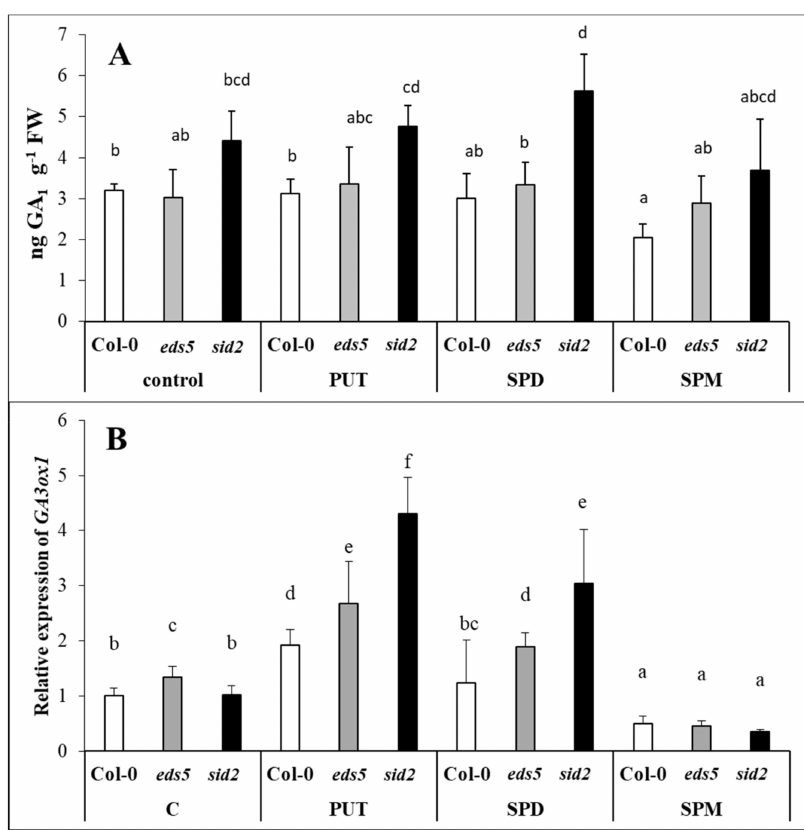
Figure 10. E ff ect of 0.5 mM 1-day of putrescine (PUT), spermidine (SPD) and spermine (SPM) treatments on the content of gibberellic acid (( A ) GA1) and the expression level of gene involved in gibberellic acid (( B ) GA3ox1: gibberellin 3-oxidase) in Col-0, wild type, eds5-1 ( eds5 ) and sid2-2 ( sid2 ) Arabidopsis mutants. Data represent mean values ± SD. Di ff erent letters indicate significant di ff erences at p ≤ 0.05